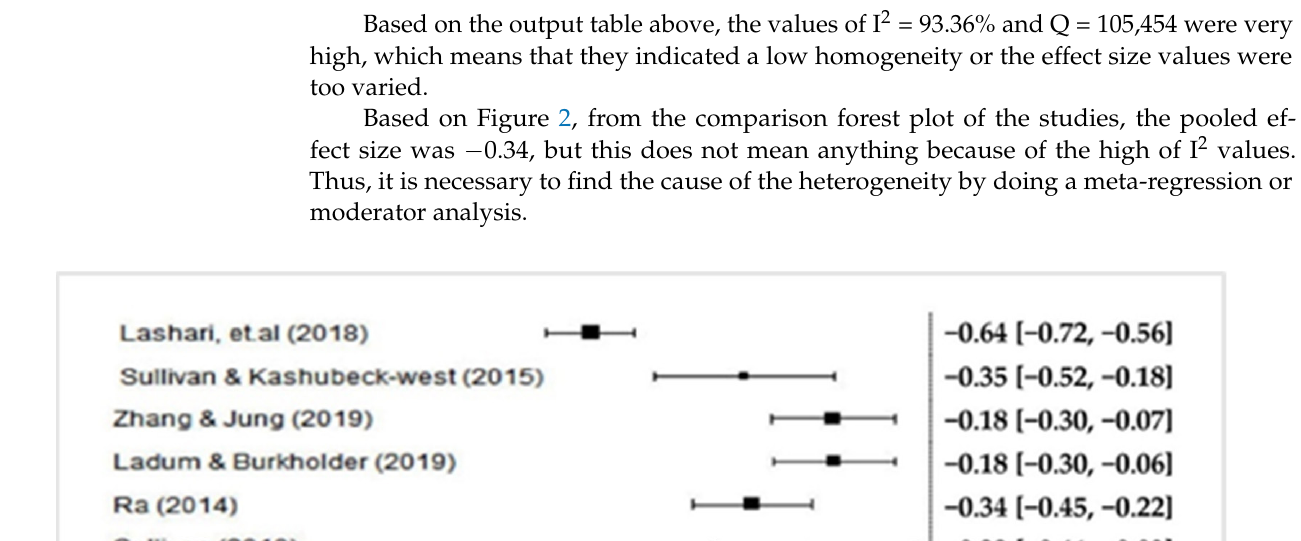
Table 3 a. Mixed effect of the study review.